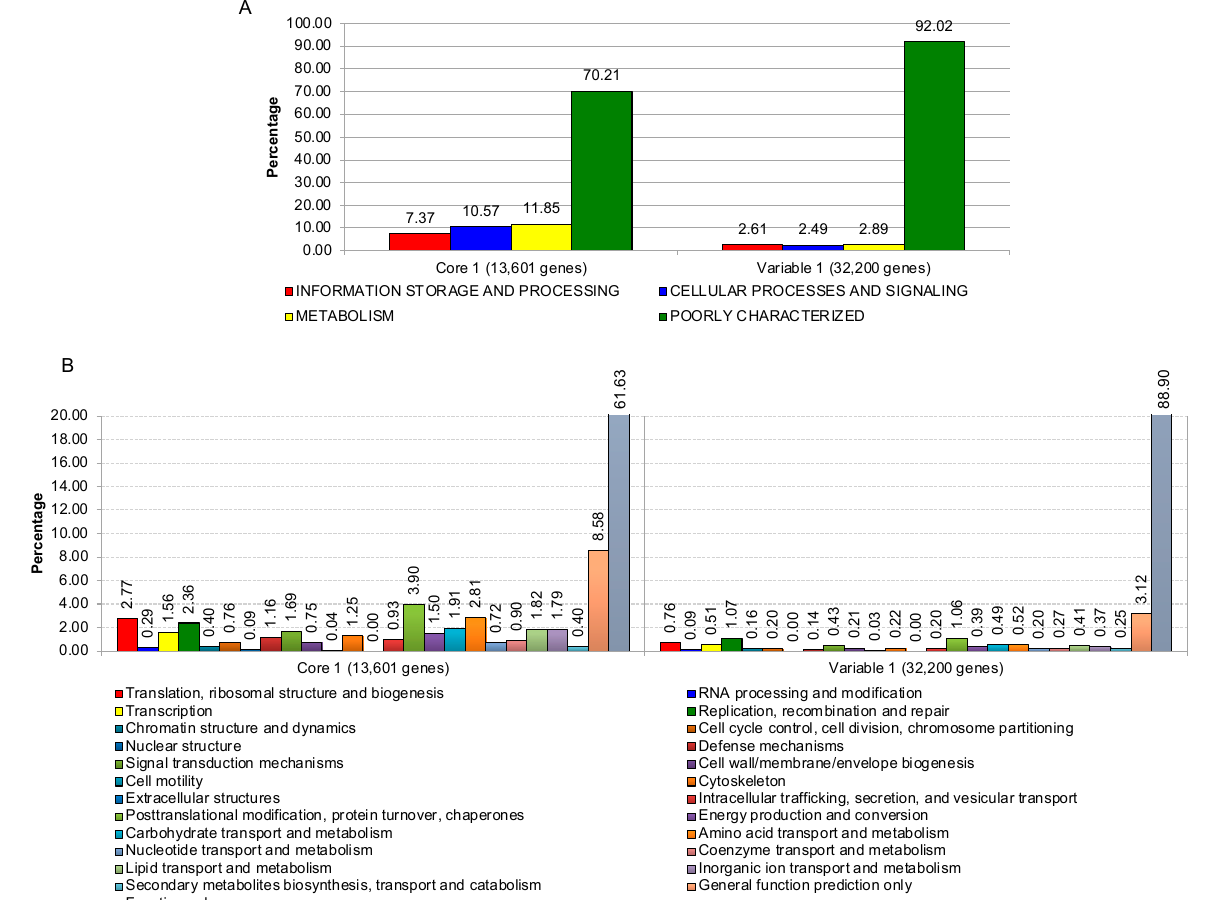
Figure 6. Functional classification of Core 1 and Variable 1 genes, derived from the pangenome analysis of 10 P. insidiosum strains and 5 other Pythium species, based on clusters of orthologous groups (COG) at superfunctional ( A ) and functional ( B ) levels.